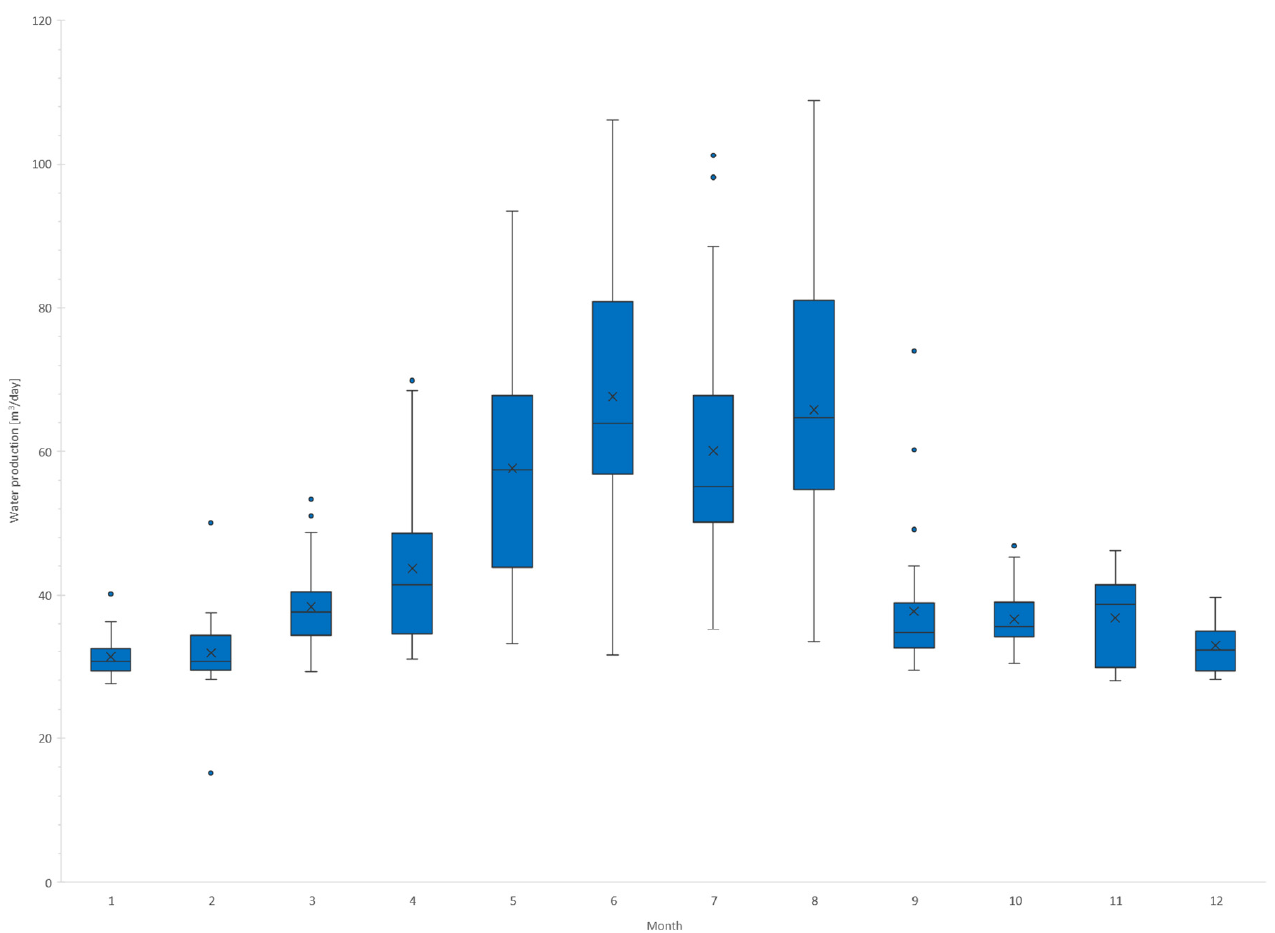
Figure 5. Daily water production during the year (the dots - outliers and x - mean).